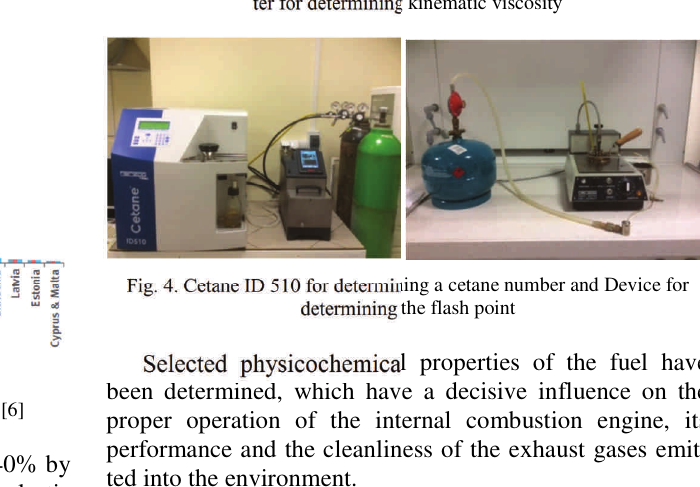
Fig. 2. Demand for Polymeric Plastics in Europe 2013-2015 [6] Plastics account for about 10% by weight and 40% by volume of the household waste. The main source of plastic waste is packaging, which accounts for 55% of post con- sumer waste from plastics.